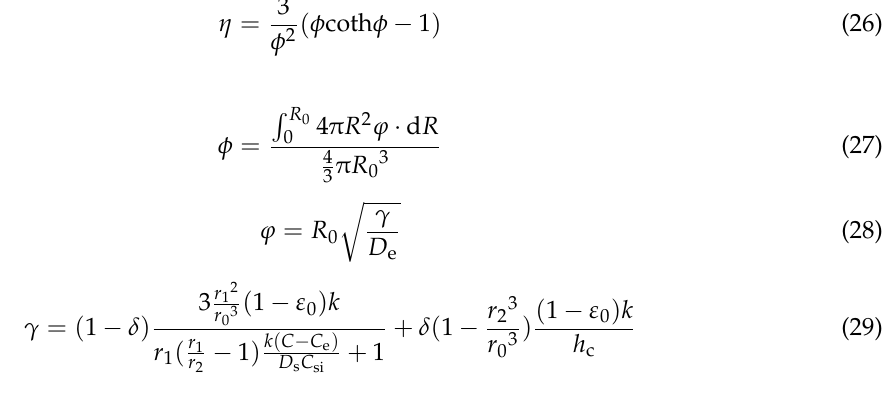
Figure 12. The importance of external mass transfer resistance described by ( C 0 − C s ) / ( C s − C e ) under different particle sizes at 800 °C.